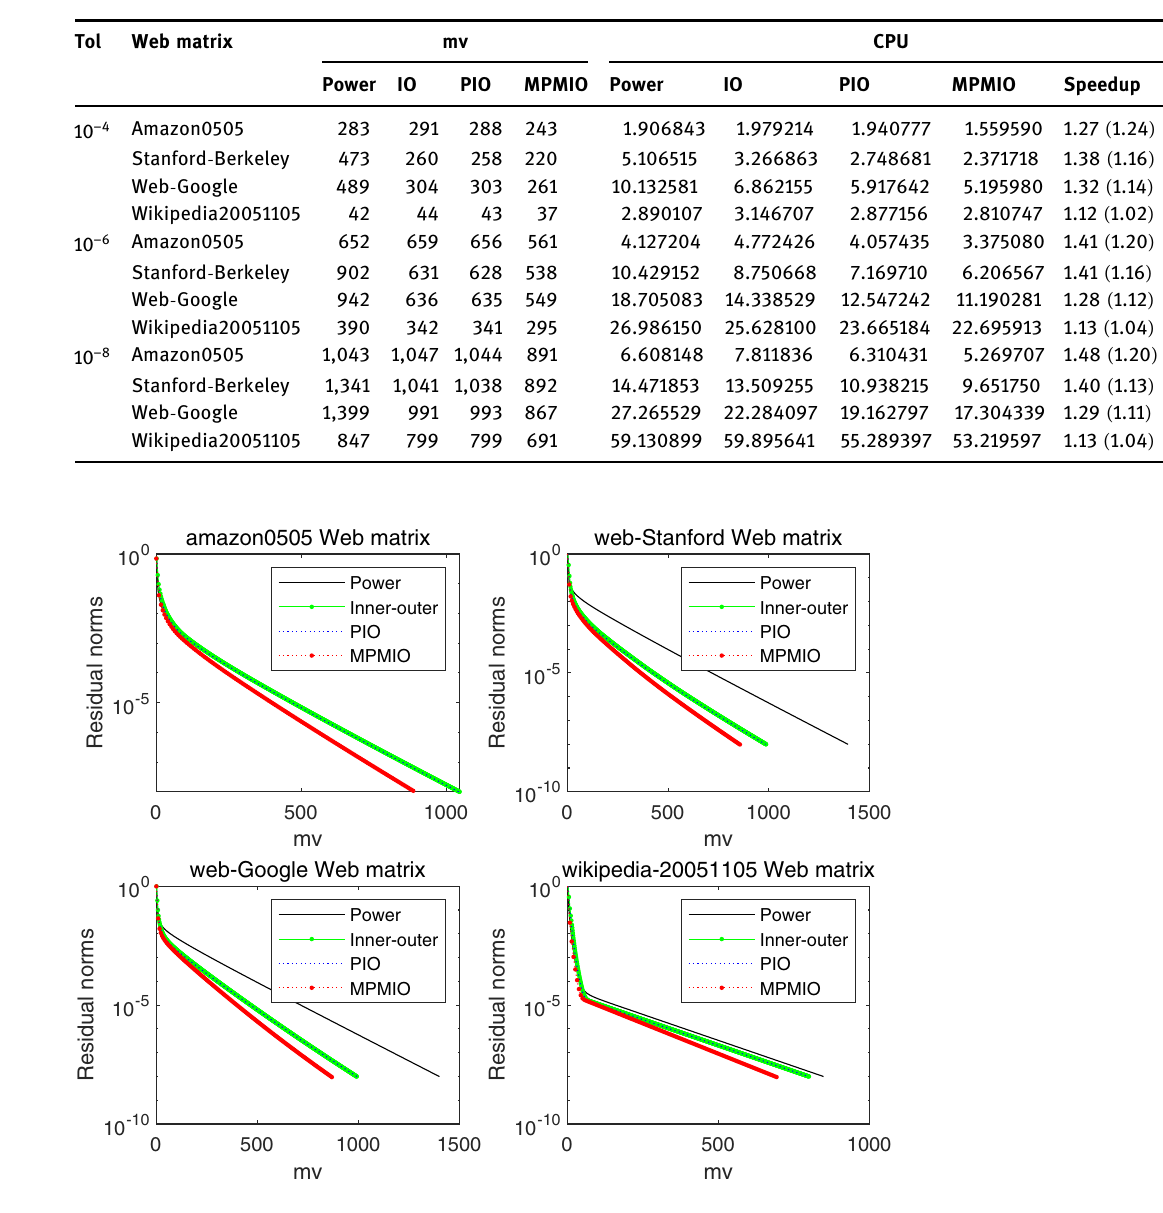
Table 4: Numerical results for Example 3 with α . Speedup represents